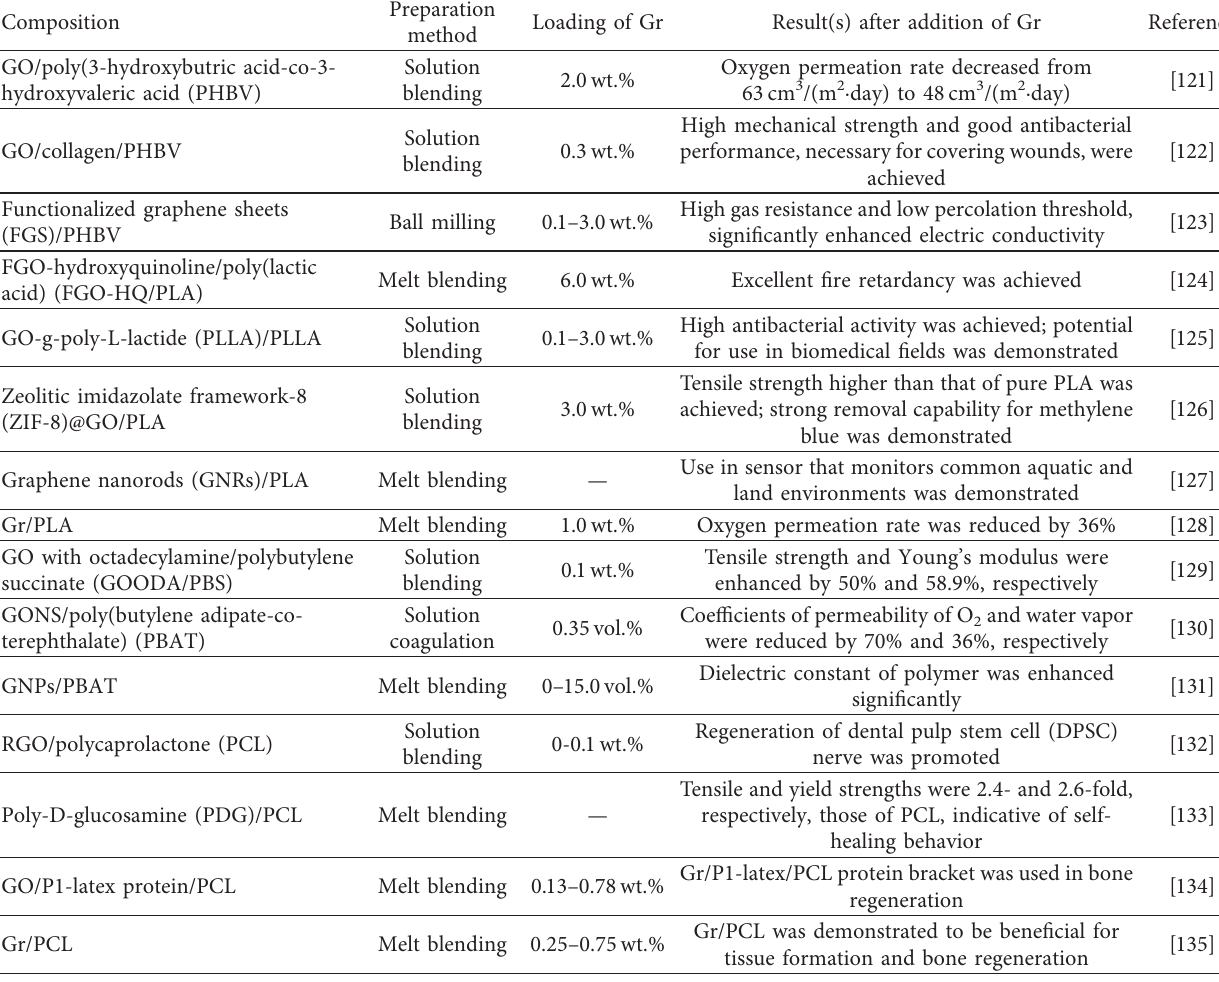
Table 7: Properties and preparation methods of composite materials comprising graphene and biodegradable polymers.